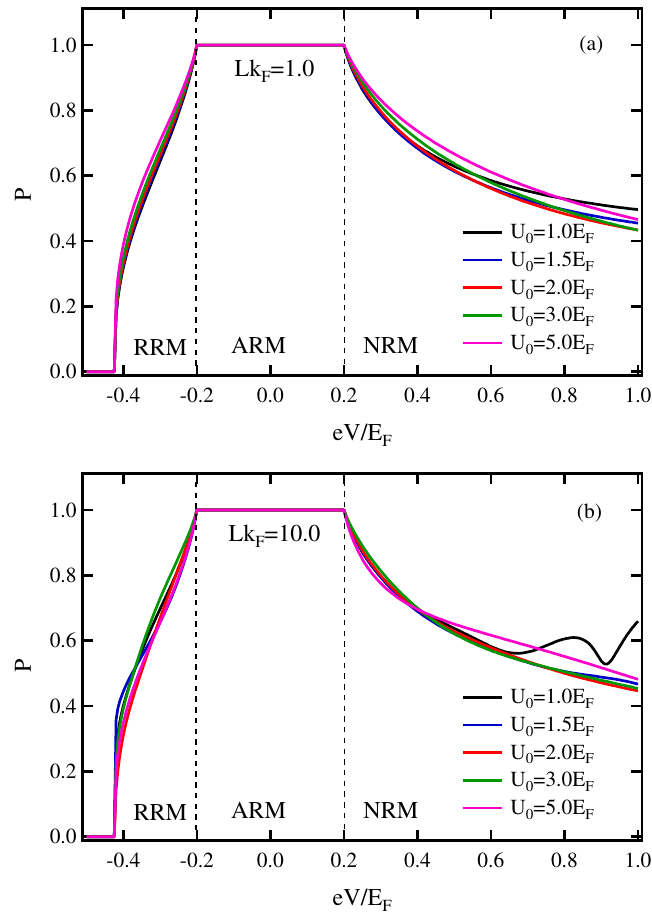
Figure 5. (Color online) Conductance spectra in the applied voltage for different values of the barrier potential in case of 0 < M 2 < E α . ( a ) Lk F = 1.0, ( b ) Lk F = 10.0. The parameters were set as the same in Figure